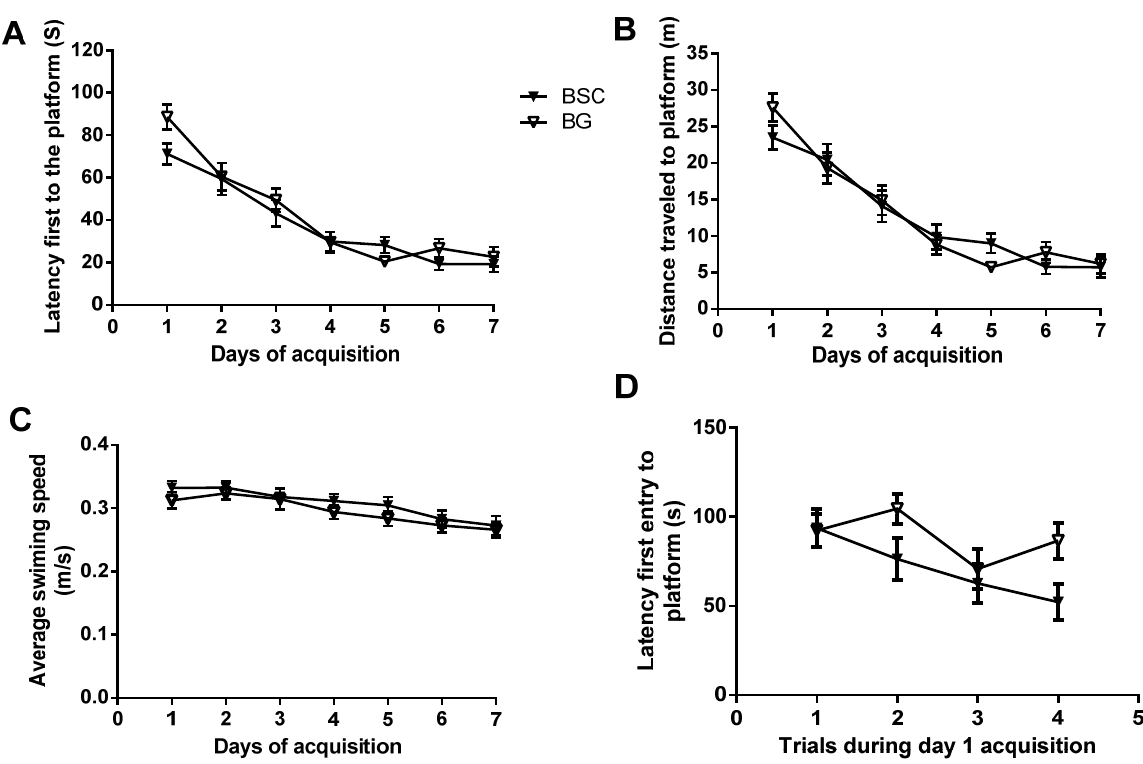
Figure 3. Performances in the Morris water maze tests performance during 7 days